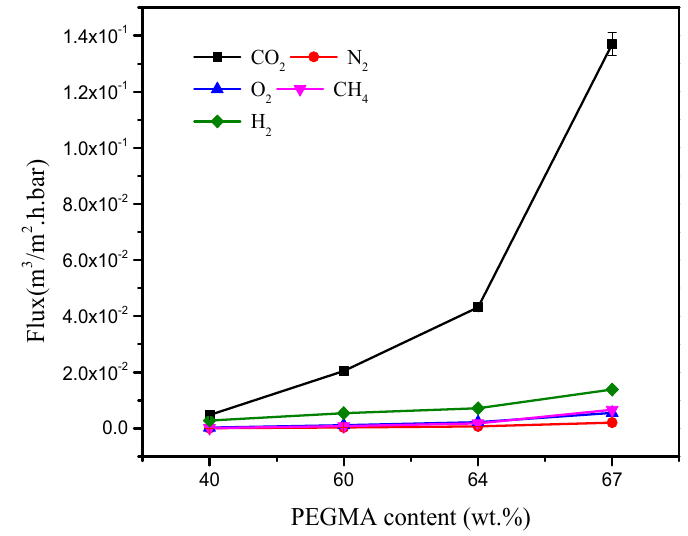
Figure 8. Plot of gas permeability against the content of PEGMA (wt %).